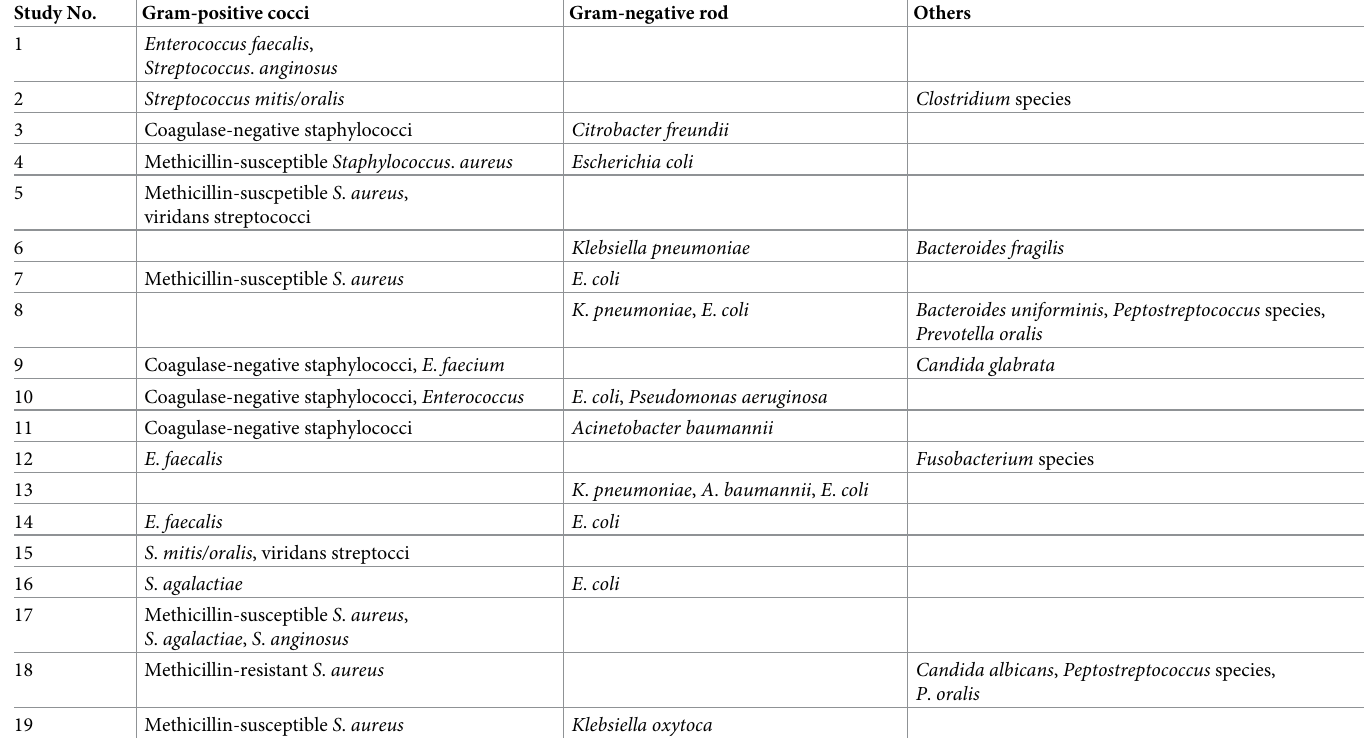
Table 3. Isolates from patients with community-onset necrotizing fasciitis by polymicrobial infection. Study No.